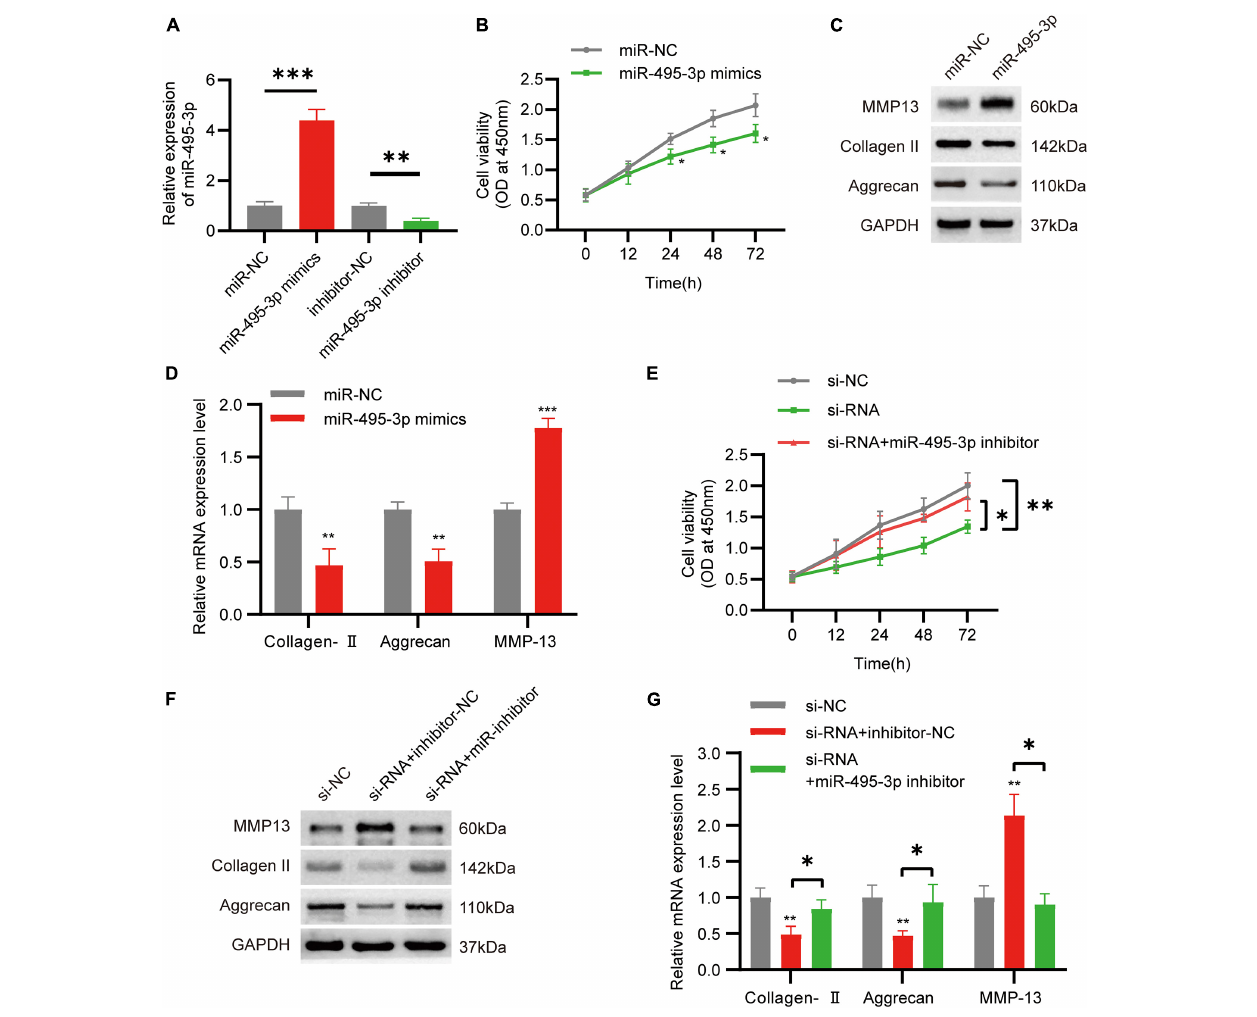
FIGURE 4 | Function of miR-495-3p in chondrocytes and miR-495-3p inhibitor reversed the effects of siRNA. (A) The expression of miR-495-3p was assessed by qRT-PCR and transfected with miR-495-3p mimics and miR-495-3p inhibitor ( ∗∗ P < 0.01, ∗∗∗ P < 0.001). (B) The effect of miR-495-3p overexpression on cell proliferation in vitro was determined by CCK8 assay ( ∗ P < 0.05). (C) Western blot analysis of MMP13, Collagen II, and Aggrecan transfected with miR-495-3p mimics. The optical density analysis was performed from the results of three independent experiments of Western blot samples ( ∗ P < 0.05, ∗∗ P < 0.01). (D) Relative mRNA expression test by qRT-PCR ( ∗∗ P < 0.01, ∗∗∗ P < 0.001). (E) Chondrocytes were co-transfected with a miR-495-3p inhibitor and siRNA; cell proliferation was monitored by CCK-8 assay ( ∗ P < 0.05, ∗∗ P < 0.01). (F) Western blot analysis of MMP13, Collagen II, and Aggrecan co-transfected with a miR-495-3p inhibitor and siRNA. The optical density analysis was performed from the results of three independent experiments of Western blot samples. (G) Relative mRNA expression test by qRT-PCR ( ∗ P <